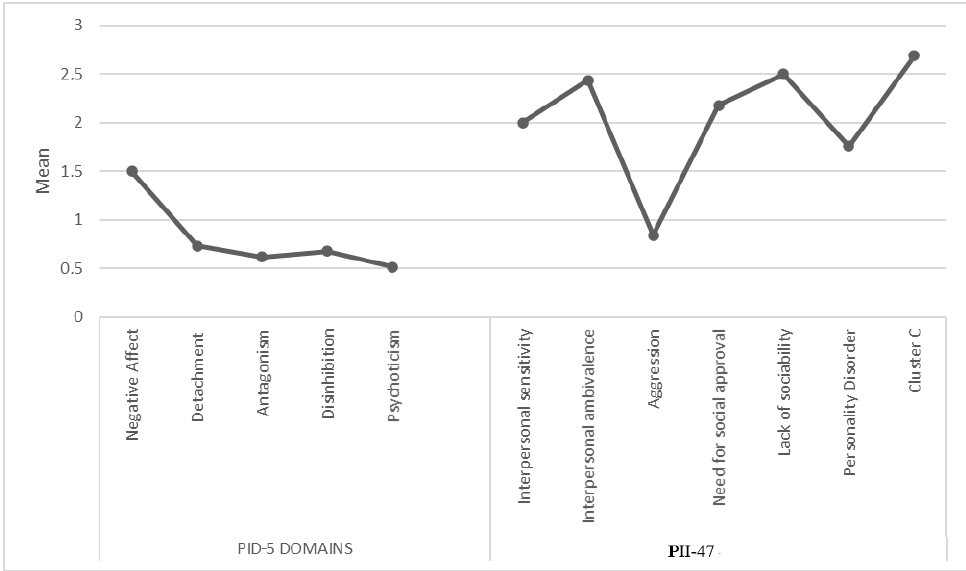
Figure 2. Representation of distribution of sub-items of PID-5 domains and sub-items of IIP-47.